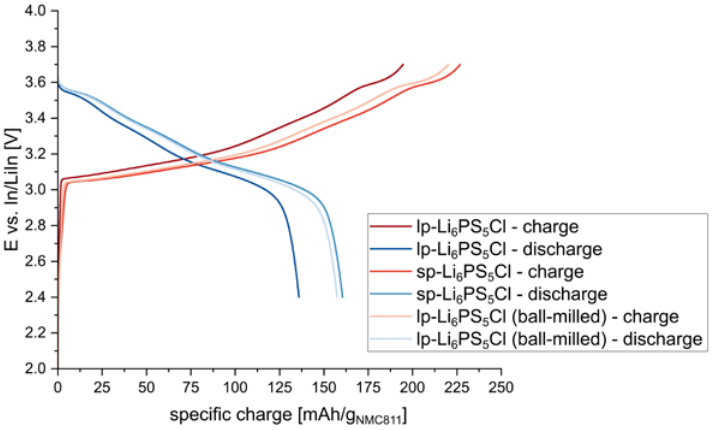
Figure 5. Potential profiles of 1st charge/discharge cycle at C/20 using different Li 6 PS 5 Cl materials for the composite NMC811 cathode (AM:SE:CA = 67:30:3 wt.%; 40:55:5 vol.%). for the composite NMC811 cathode (AM:SE:CA = 67:30:3 wt.%; 40:55:5